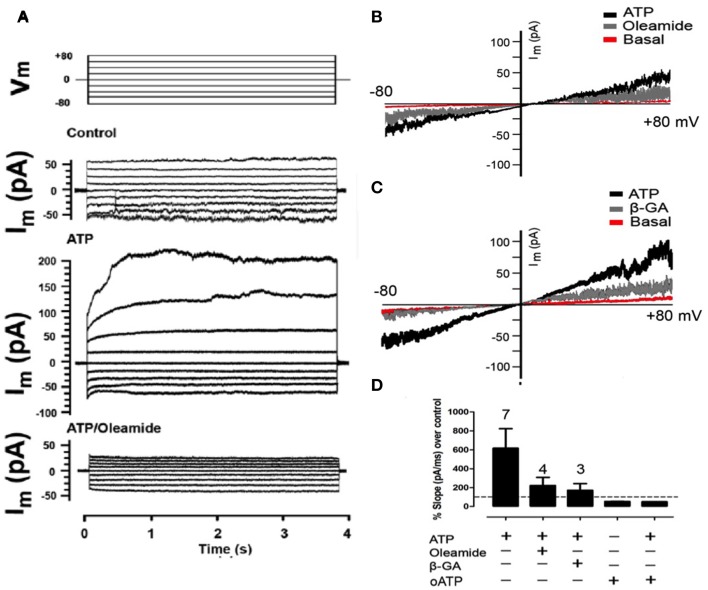
Extracellular ATP enhances the membrane current mediated by Panx1 channels. Representative I/V curve of total membrane current recorded in freshly seeded RCs evaluated under voltage clamp by using the whole cell patch clamp configuration. Rectangular voltage steps or voltage ramp between −80 and +80 mV were applied during ~4 or 20 s, respectively. (A) Top traces correspond to the protocol of voltage commands (Vm) applied and the other traces correspond to a representative set of currents recorded under control conditions, after treatment with 300 μM ATP or simultaneous treatment with 100 μM oleamide and 300 μM ATP. (B,C) The membrane current promoted by voltage ramp under resting conditions (Basal), followed by the application of 150 μM ATP and then, the application of (A) 100 μM oleamide or (B) 50 μM β-GA. (D) Bar graph showing the percentage with respect to control conditions of the slope of membrane currents, in the presence (+) or absence (–) of ATP, 100 μM oleamide, 50 μM β-GA as described above or 150 μM oATP in the absence or presence of 150 μM ATP. The digit above each bar indicates the number of experiments.